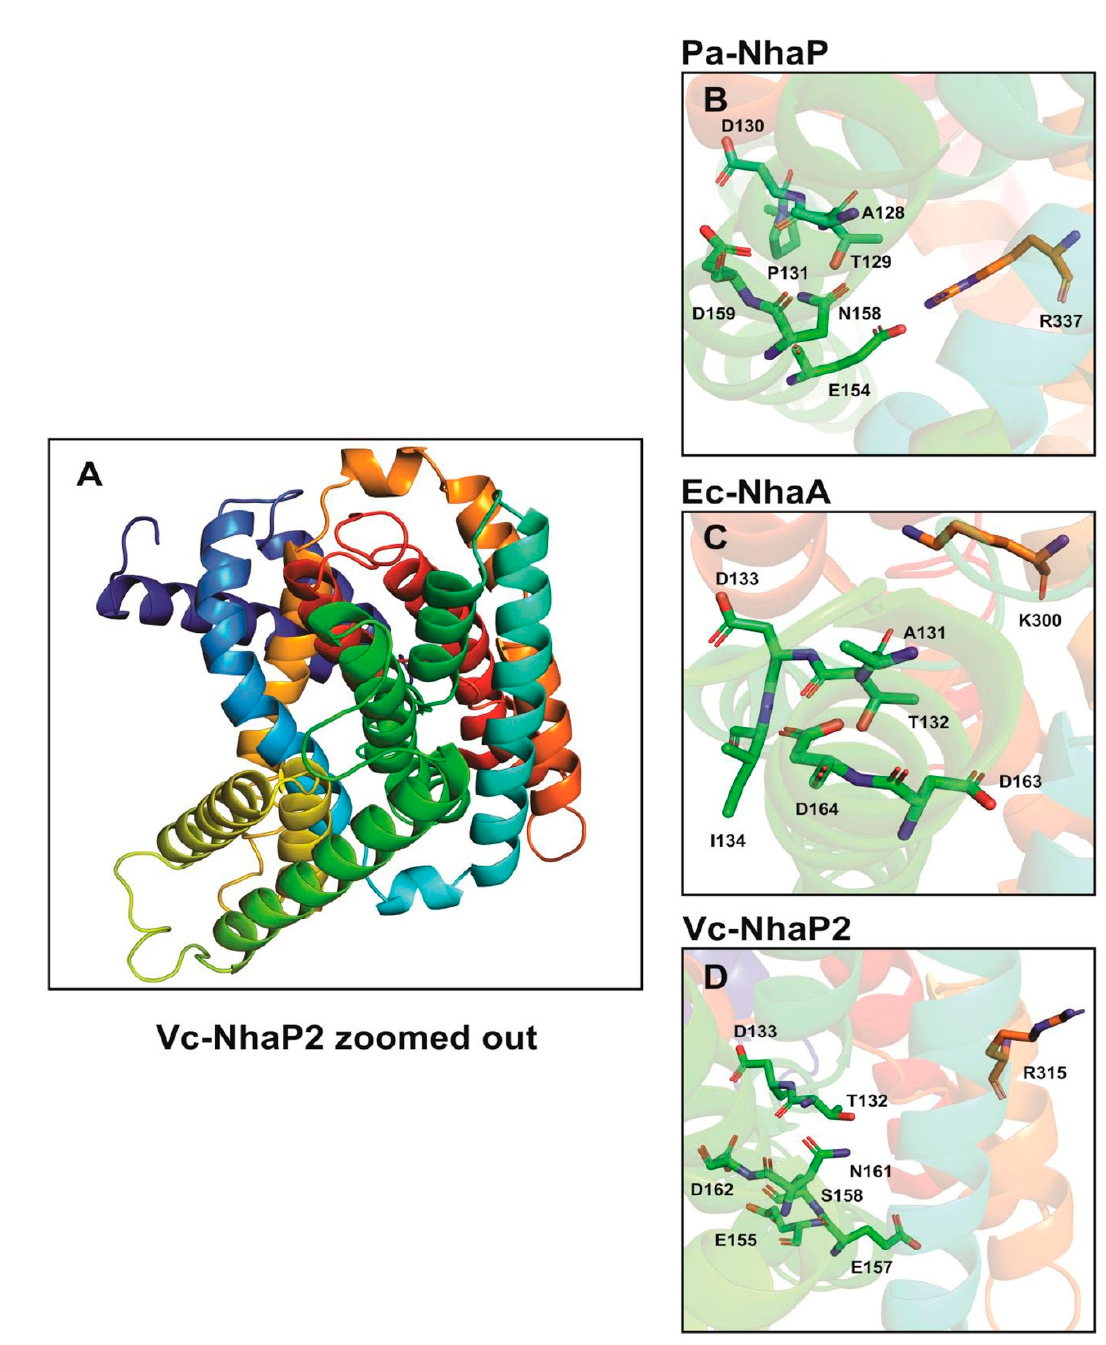
Figure 2. Amino acid residues implicated in ion binding in NhaP-type antiporters. Structural data for proteins from NhaP2 of V. cholerae (Vc-NhaP2) (based on data from [15]) ( A , D ), Pyrococcus abyssii (Pa-NhaP) (PDB accession code: 4CZA) ( B ) and NhaA of E. coli (Ec-NhaA) (PDB accession code: 1ZCD) ( C ) were used to generate 3D images with PyMOL 1.6 [34]. Amino acid residues are shown in stick-and-surface representation.